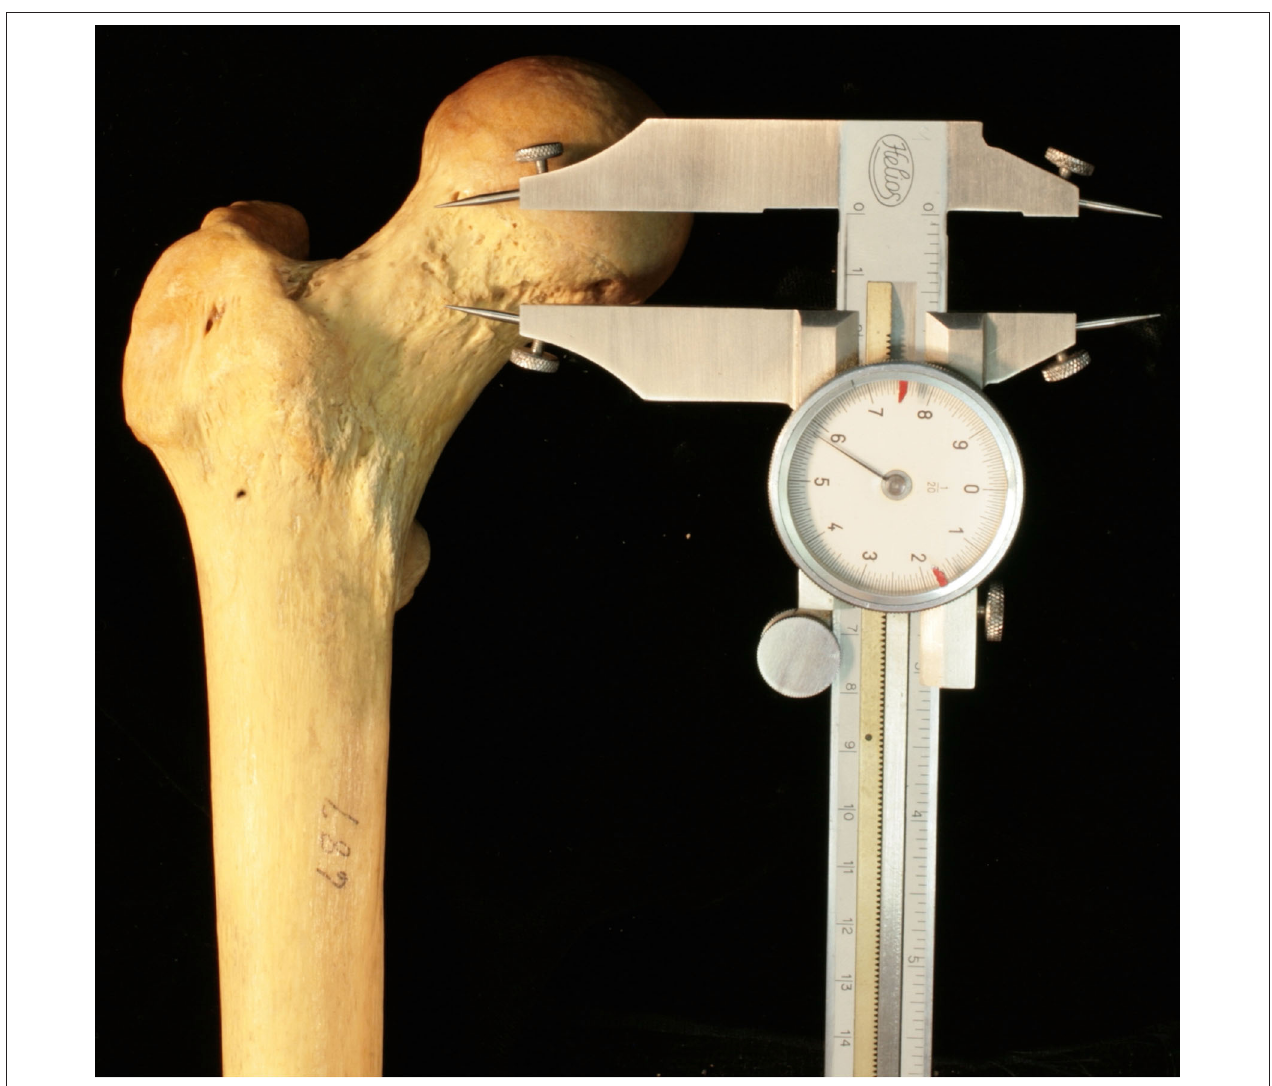
FIGURE 3 | Coronal view of a cadaveric femur demonstrating the use of digital calipers used to measure the length of a cam lesion from superior to